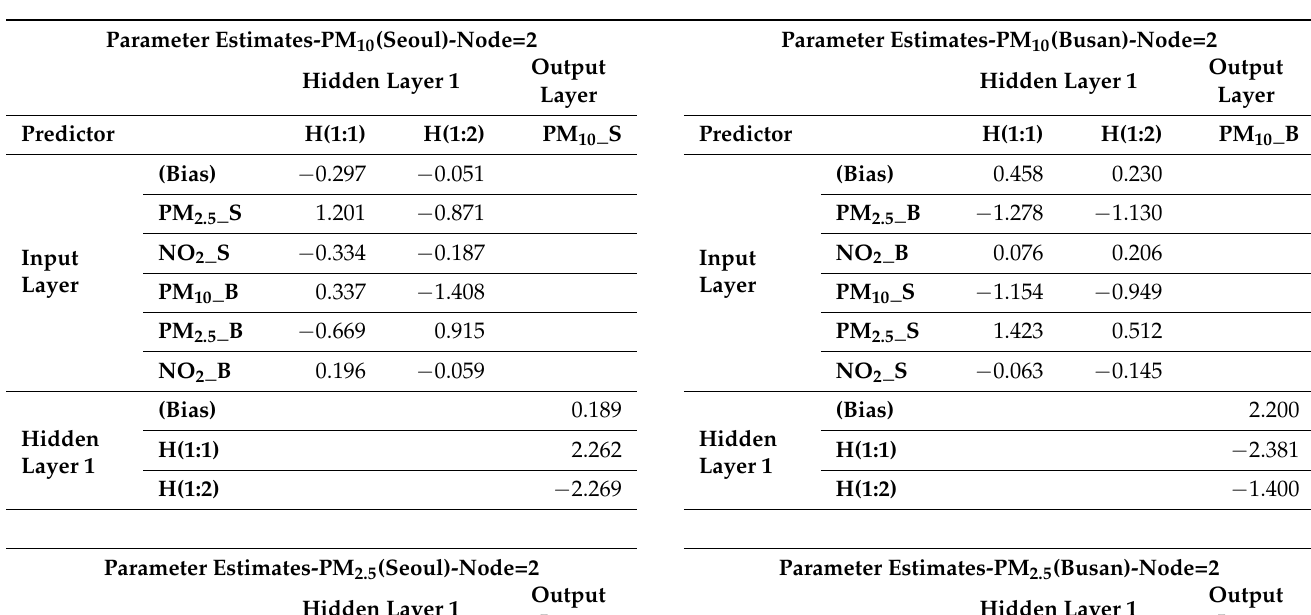
Table 1. Parameter estimates of weights and threshold values in the case of 2 nodes in one hidden layer in Seoul and Busan